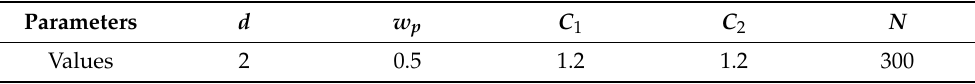
Table 1. Parameter settings of the PSO